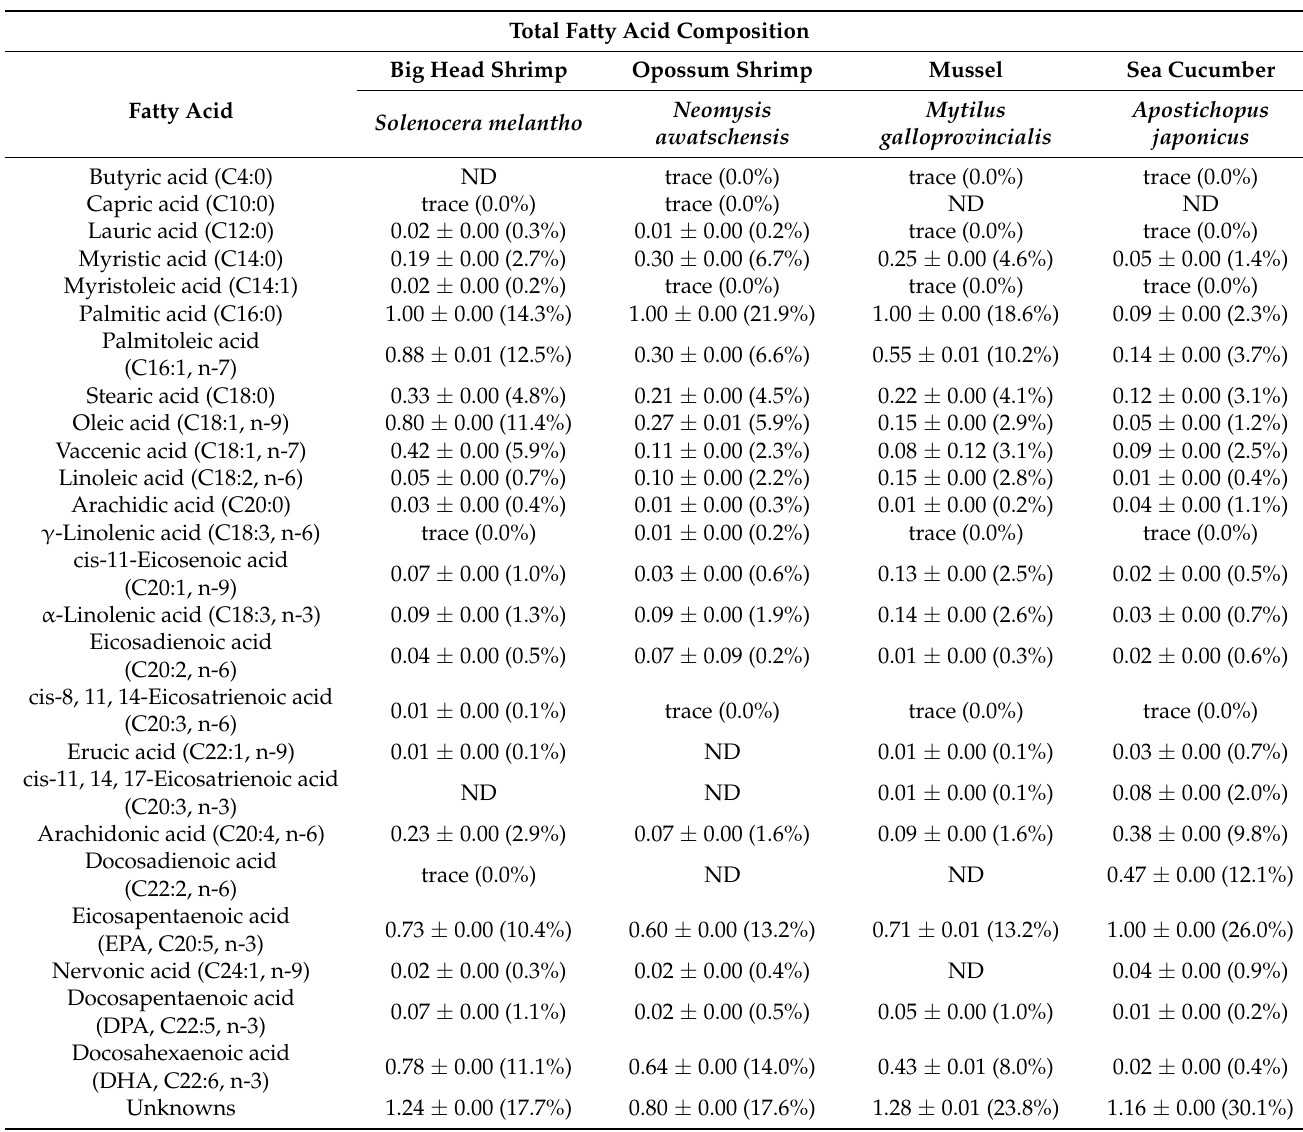
Table 5. Fatty acid composition (area %) and relative index of total lipids extracted from the dried big head shrimp, opossum shrimp, mussel, and sea cucumber. Relative index = value of each fatty acid area/value of the largest known fatty acid